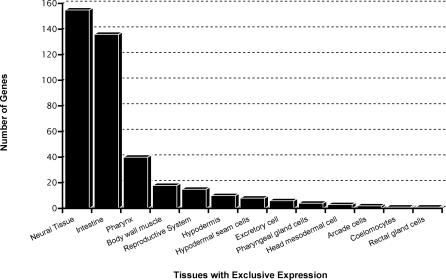
A Categorization by Tissue, Summarizing the Influence of the 389 5′ DNA Sequences that Drive Expression in a Single Tissue or Cell Type